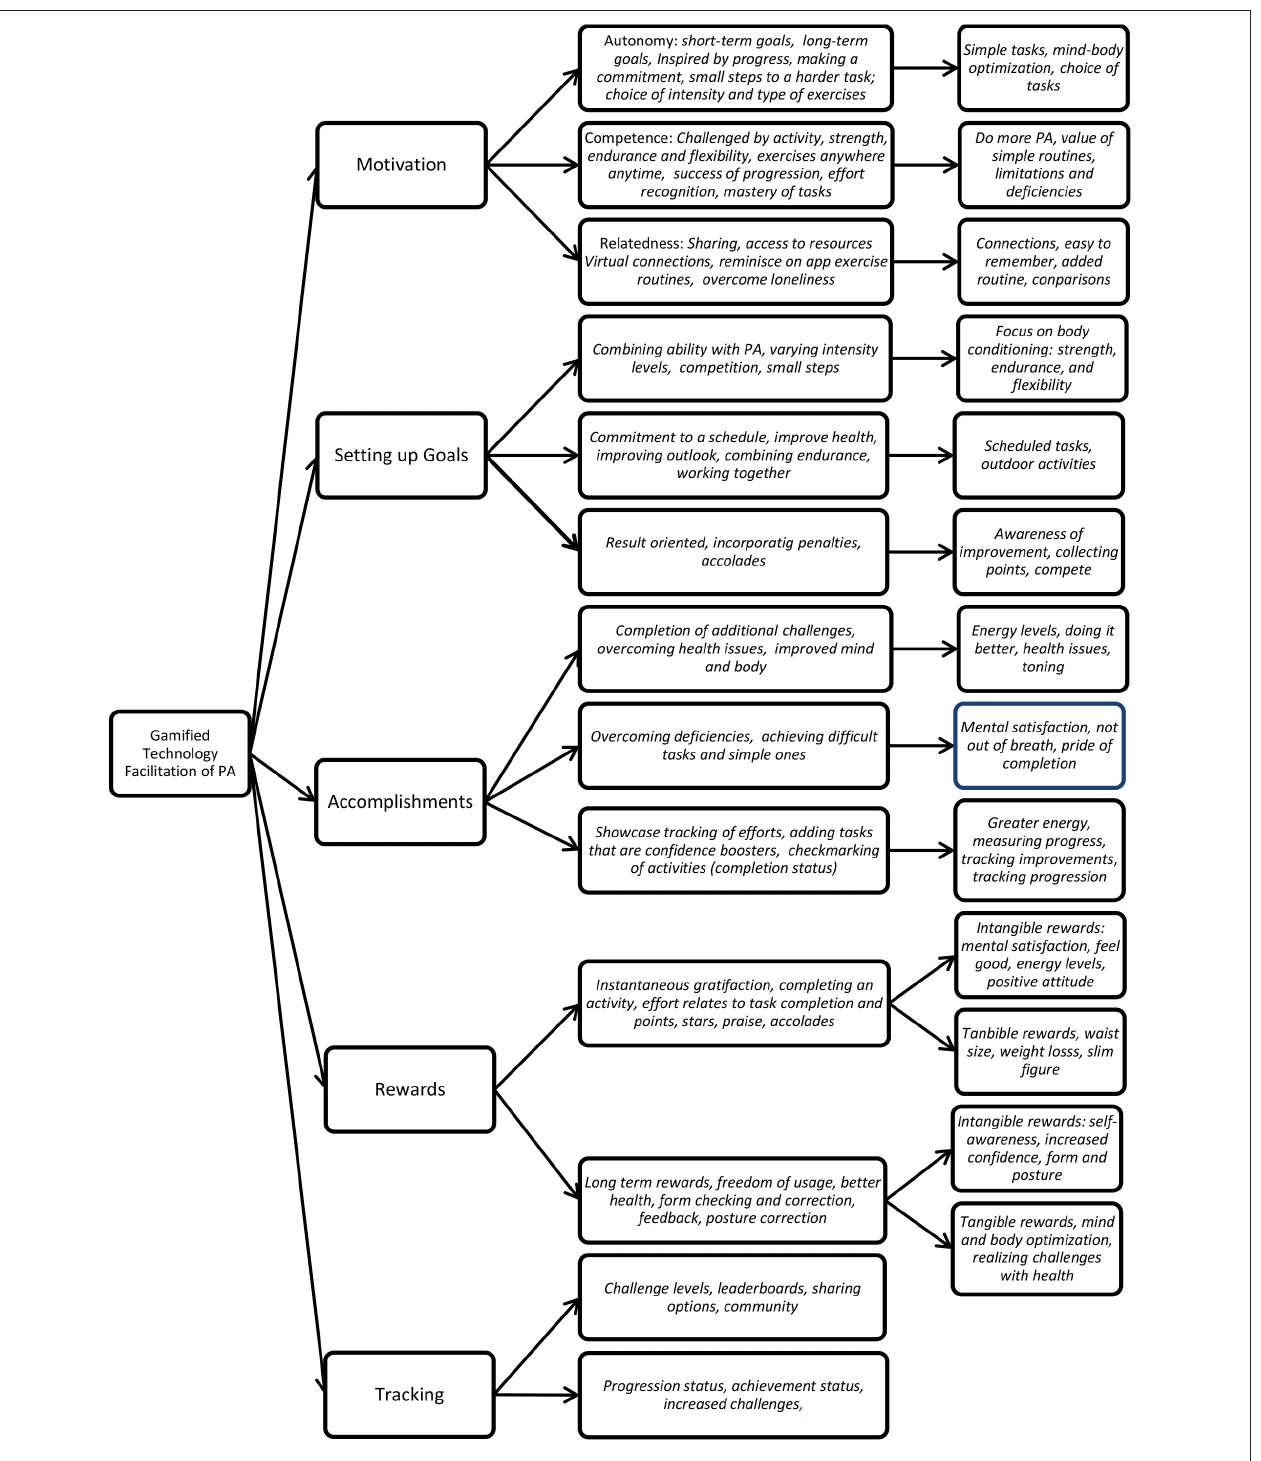
FIGURE 2 | Evidential chain showing motivational affordances from TA.